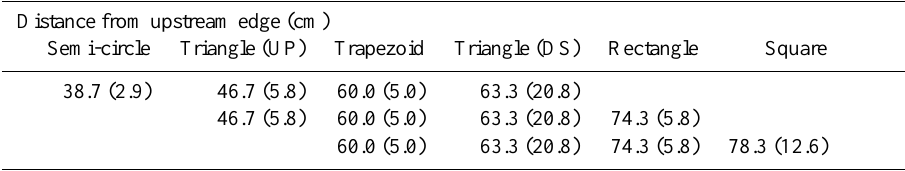
Table 6. Comparison of means results for obstruction shape versus distance from the upstream edge of the constriction to the riffle crest. Mean values contained within the same horizontal line are not significantly different from each other. Values in parentheses are the corre- sponding standard